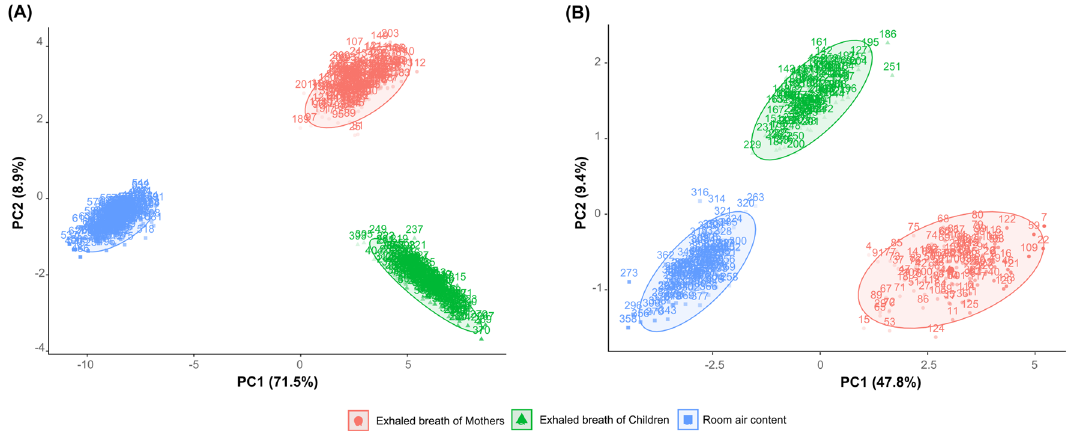
Figure 6. Explorative analysis of filtered features by principal component analysis (PCA). ( A ) PCA score plot (PC-1 vs. PC-2) of breath samples from Group 1. ( B ) PCA score plot (PC-1 vs. PC-2) of breath samples from Group